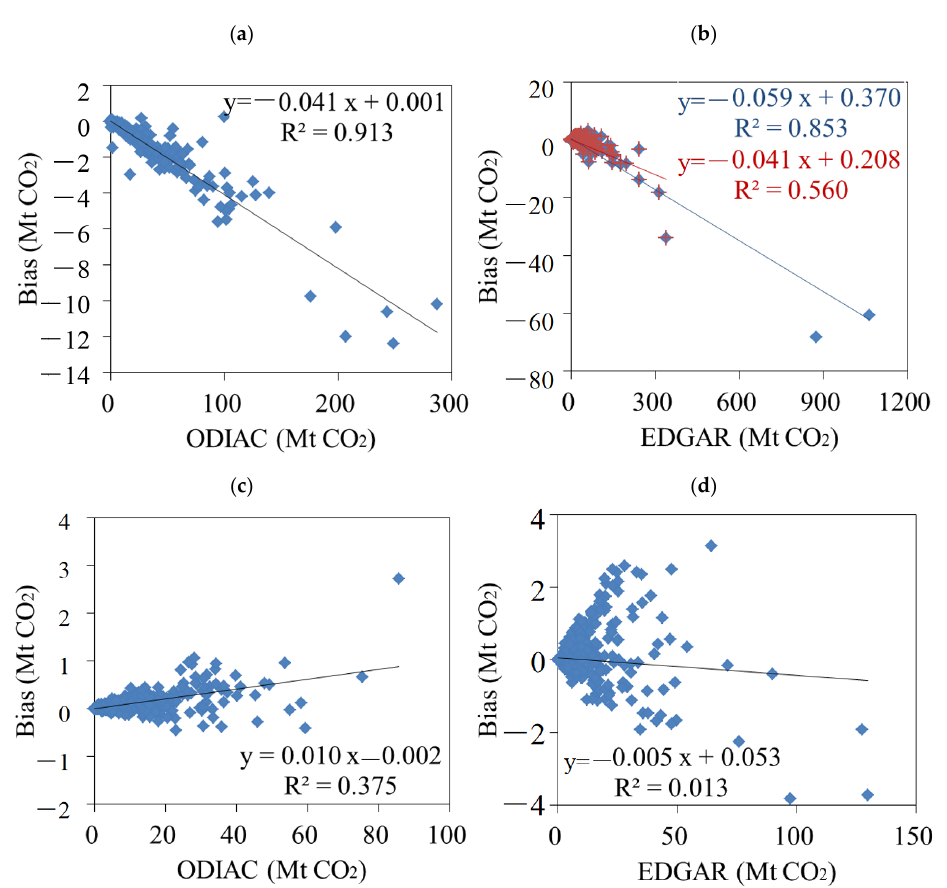
Figure A4. Averages of monthly inventories and predicted emissions based on the GRNN using satellite observations in 2019 for ( a ) original ODIAC, ( b ) predicted emissions for ODIAC, ( c ) original EDGAR, ( d ) predicted emissions for EDGAR, ( e ) bias for ODIAC, and ( f ) bias for EDGAR.